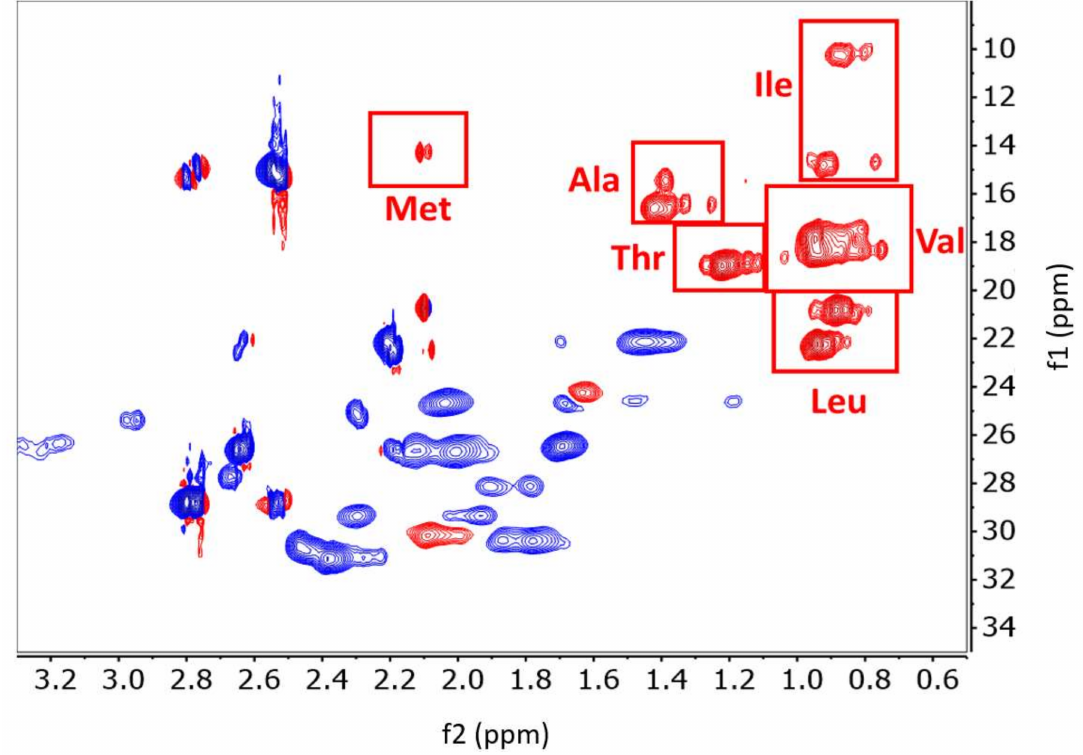
Figure 4. Multiplicity-edited 2D 1 H- 13 C HSQC spectra of the unfolded state of IgG2. Red peaks are either CH or CH 3 , blue peaks are CH 2 . The methyl groups of each amino acid are shown in red boxes corresponding to the random coil 1 H and 13 C shift ranges for the six methyl groups [12]. 1 H is represented on the x axis (f2), and 13 C is represented on the y axis